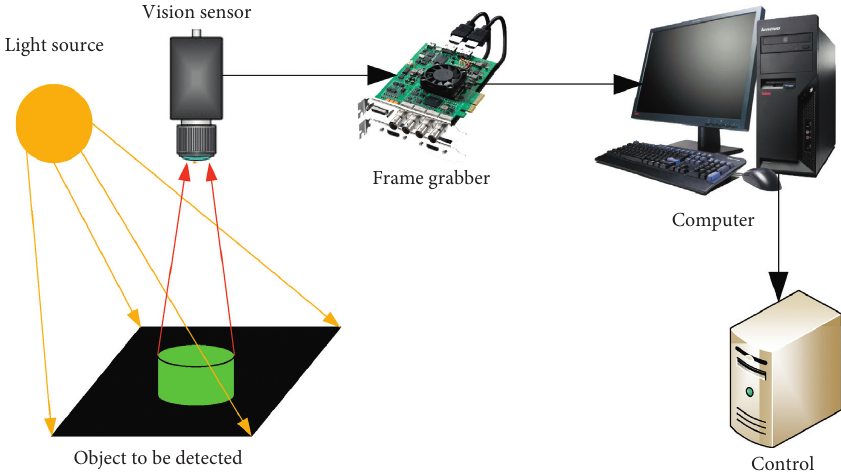
Figure 1: Composition of the machine vision